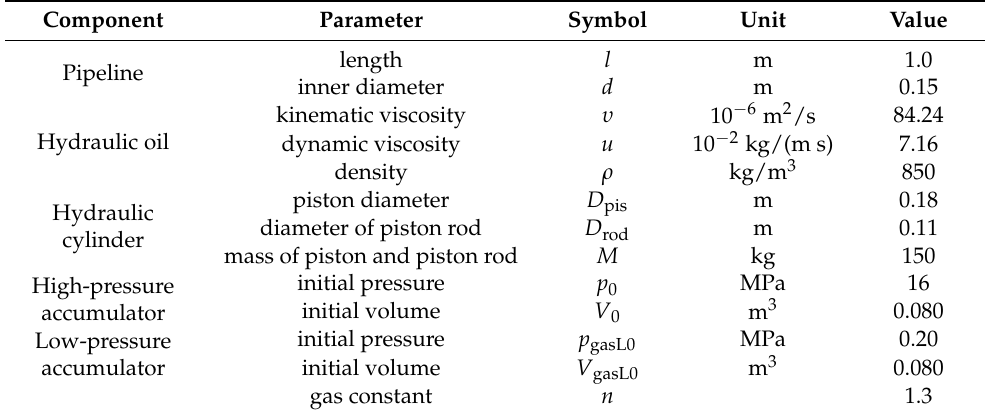
Table 1. HPT parameters and initial values.